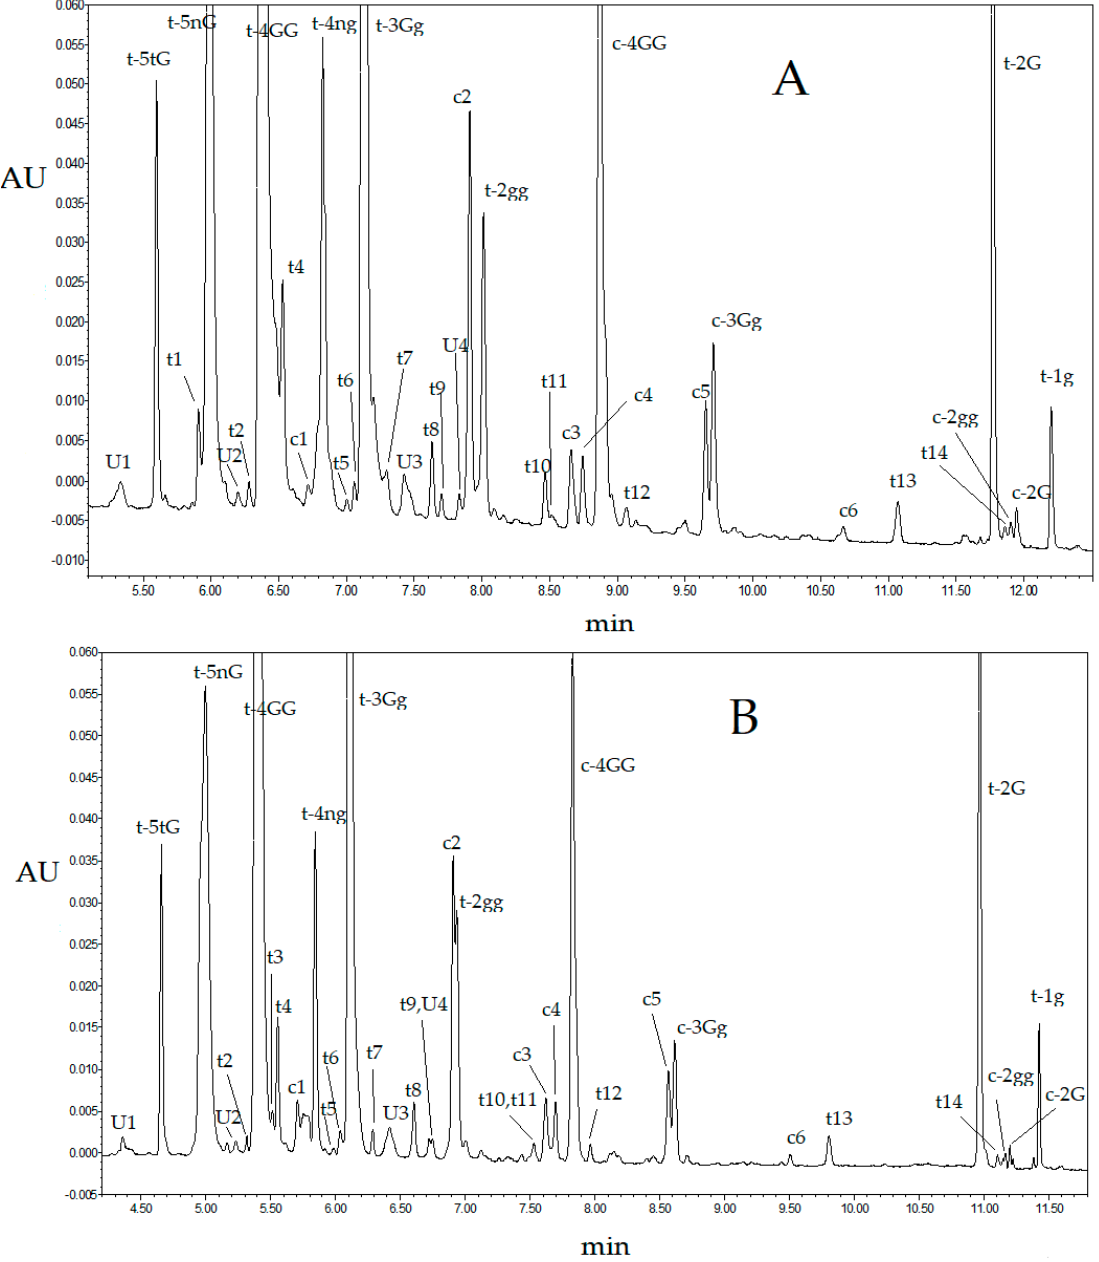
Figure 1. Ultra high-performance liquid-chromatography-diode-array (UHPLC-DAD) chromatograms detected at 440 nm of a saffron extract obtained with the column Kinetex C18 at ( A ) t g = 10 min, T = 25 °C and ( B ) φ = 0.60 mL/min and t g = 10 min, T = 25 °C and φ = 1.00 mL/min. Peak assignments are reported in Table 1.